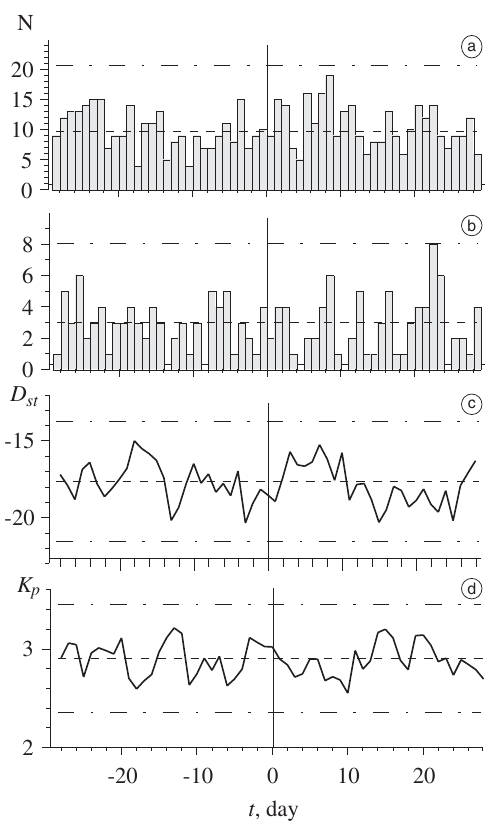
Fig. 12a-d. Daily number of m b > 5 remote earth- quakes (up to 1500 km) in the area (a) of the North- ern Tien Shan and adjacent territories, b) of semi- palatinsk underground nuclear explosions, averaged (c) D st and (d) K p geomagnetic indices before ( t < 0) and after ( t > 0) 114 MHD-generator runs on the Bishkek test site plotted against time (in days). The dashed lines indicate a mean background level and 99% confidence